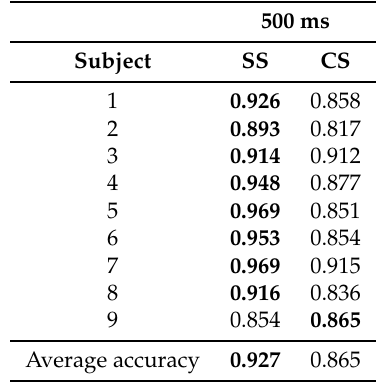
Table 4. Comparison between the accuracy rates obtained for the single-subject (SS) and combined subject (CS) approaches for the CNN model with 1 layer, convolution patch [4 × 1] and pool patch [3 × 2].